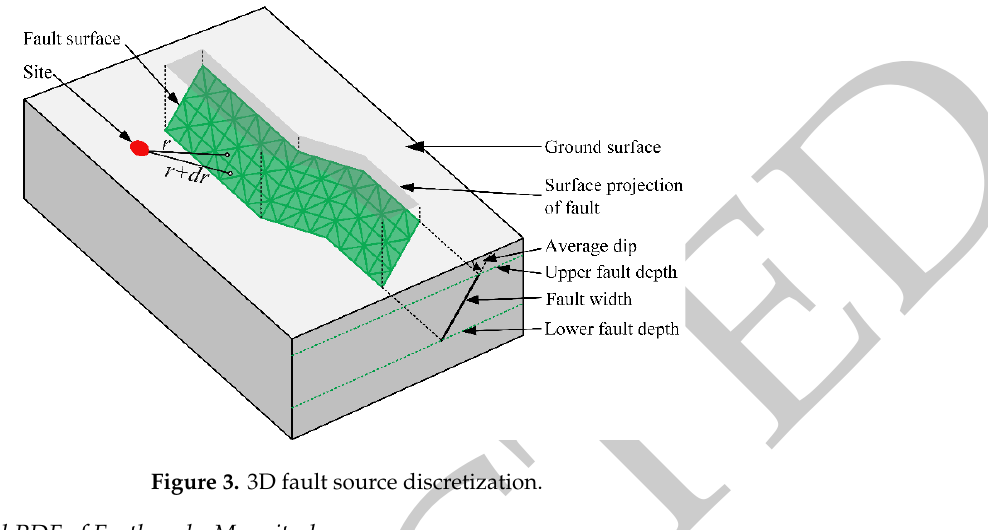
Figure 3. 3D fault source discretization.